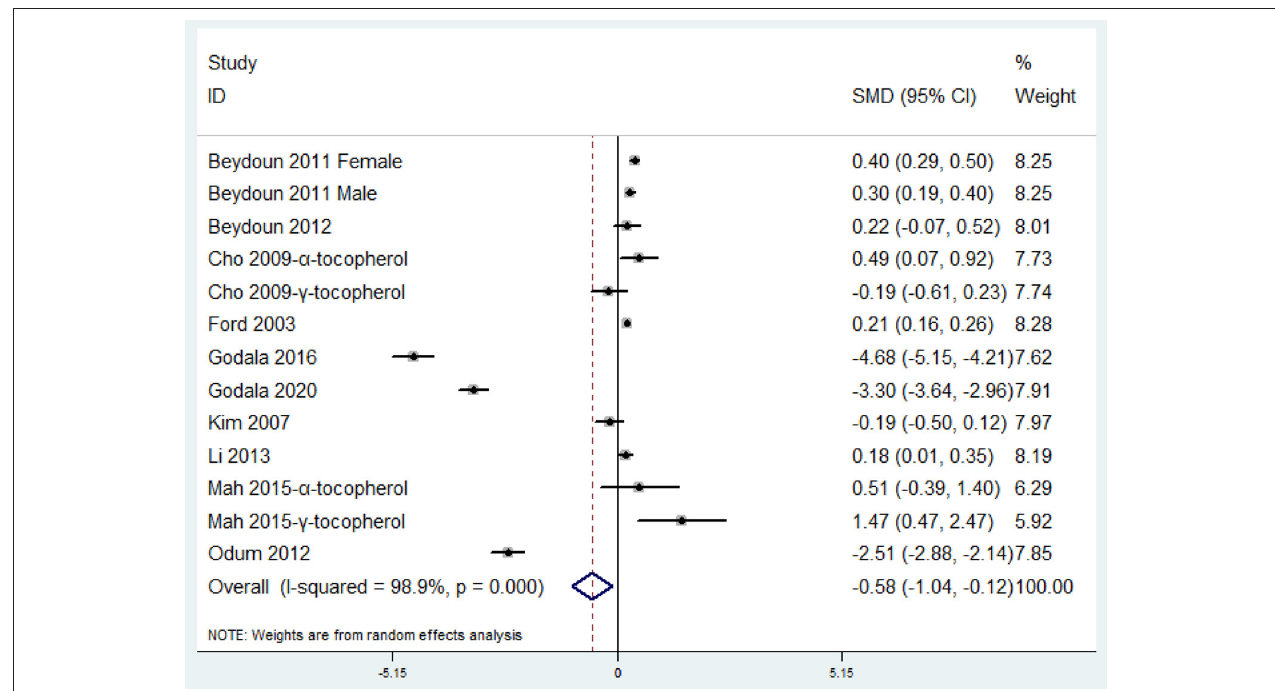
FIGURE 5 | Forest plot of meta-analysis: SMD of circulating vitamin E level for MetS vs. control subjects.